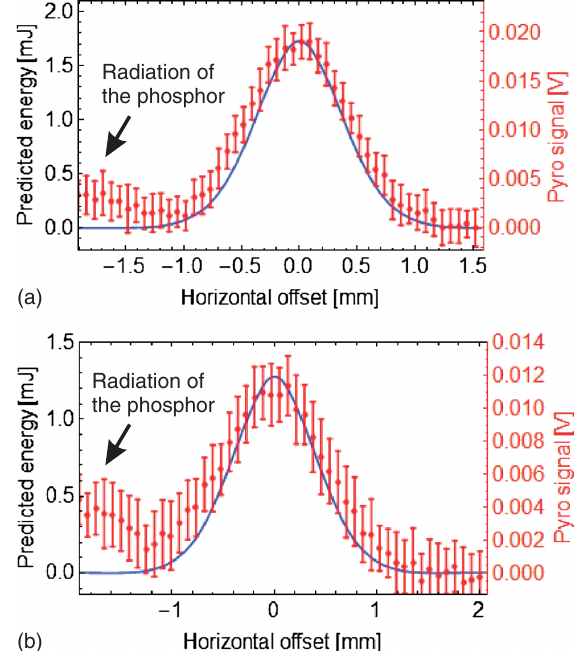
FIG. 15. Predicted (blue curve) and measured with the inter- ferometer pyrodetector (red) pulse energy in a function of the horizontal position of a 3.2 nC electron beam, for the copper structure with gap ¼ 1 . 3 mm (a) and gap ¼ 1 . 5 mm (b).